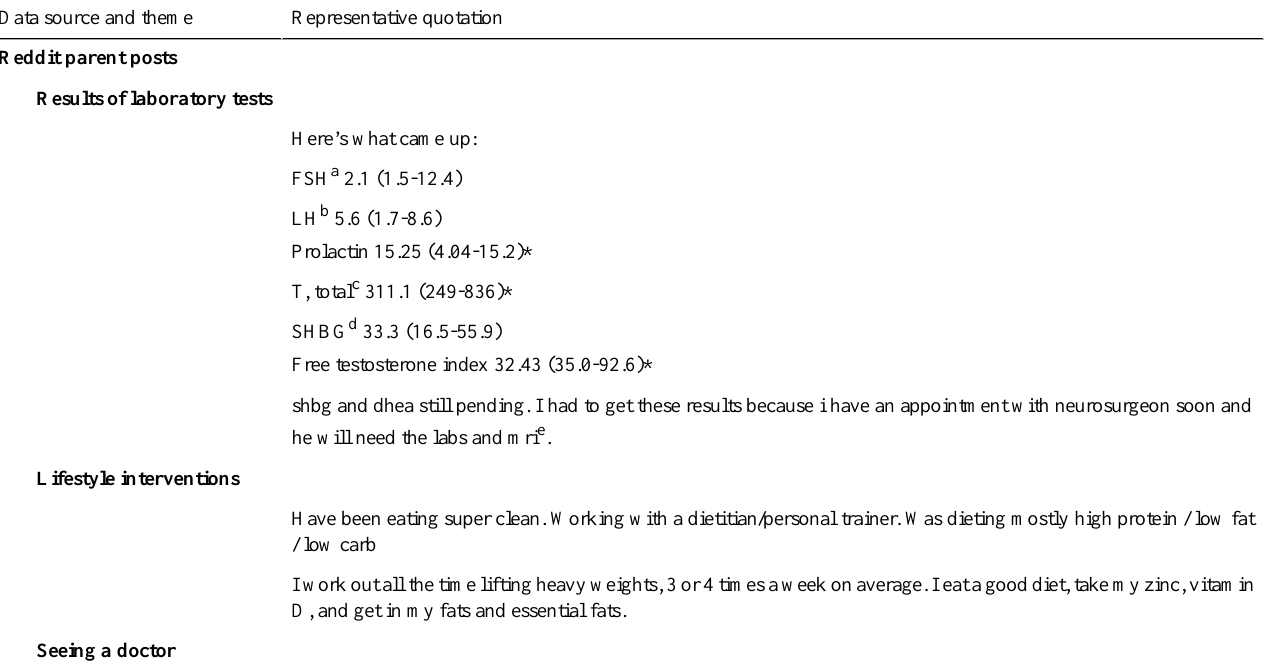
Table 3. Representative quotations for each theme derived from the meaning extraction method. Asterisks are part of the quotations and do not refer to anything in the